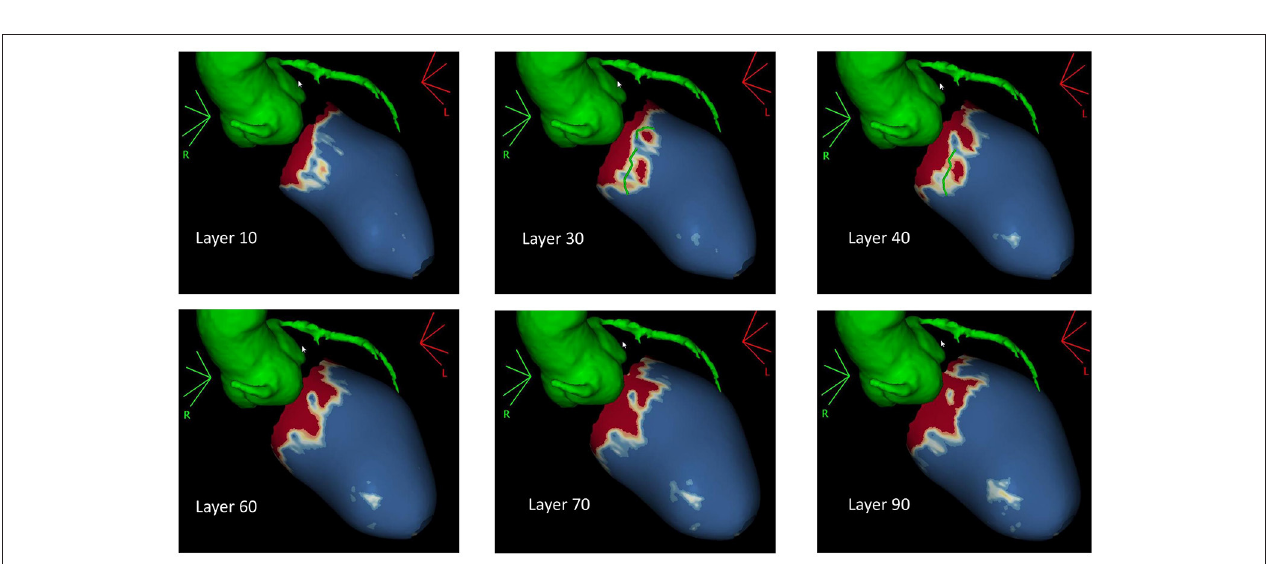
FIGURE 3 | Pixel signal intensity maps obtained through post-processing of three-dimensional (3D) late gadolinium enhancement (LGE) MRI images at different layers of left ventricular (LV) wall thickness as obtained with ADAS3D software (ADAS3D Medical S.L., Barcelona, Spain). Conduction channels are evident on the mid-myocardial layers (30–40%) and are marked by green lines. Dense scar is depicted in red, while normal myocardium is represented in blue. Border zone tissue is shown in shades of red. Courtesy of Dr. Giulio Zucchelli, Second Division of Cardiovascular Diseases, Cardio-Thoracic and Vascular Department, University Hospital of Pisa, Pisa, IT,